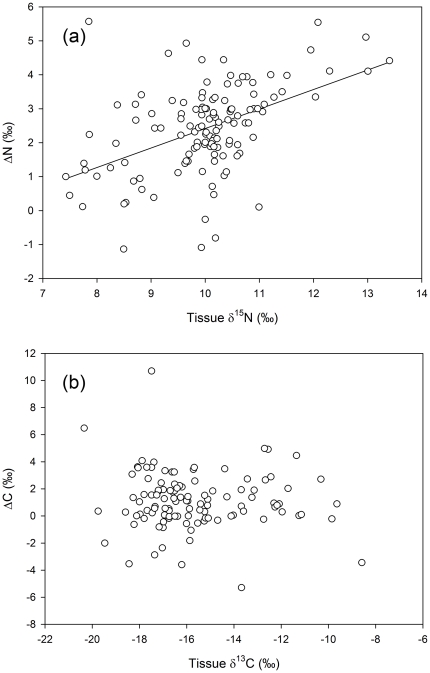
Fish tissue isotopes compared to gut content isotopes.Data shows isotope ratios at the time of sampling for (a) nitrogen (δ15N, n = 126) and (b) carbon (δ13C, n = 111). Solid lines represents significant linear regression relationships for nitrogen (Tissue δ15N = 0.325×Gut δ15N+7.535; r2 = 0.138; F[1,124] = 19.93, p<0.001) and carbon (Tissue δ13C = 0.547×Gut δ13C−6.472; r2 = 0.583; F[1,109] = 152.2, p<0.001).